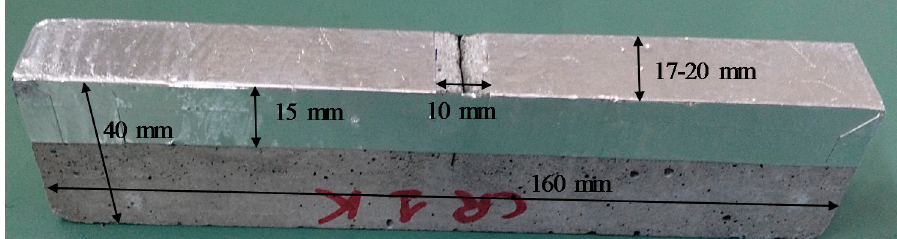
Figure 2. Mortar sample, with one standard crack (CR_1), covered with aluminum tape.